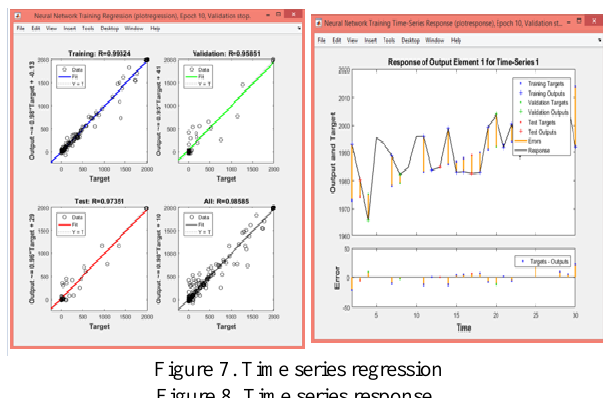
Figure 7. Time series regression Figure 8. Time series response